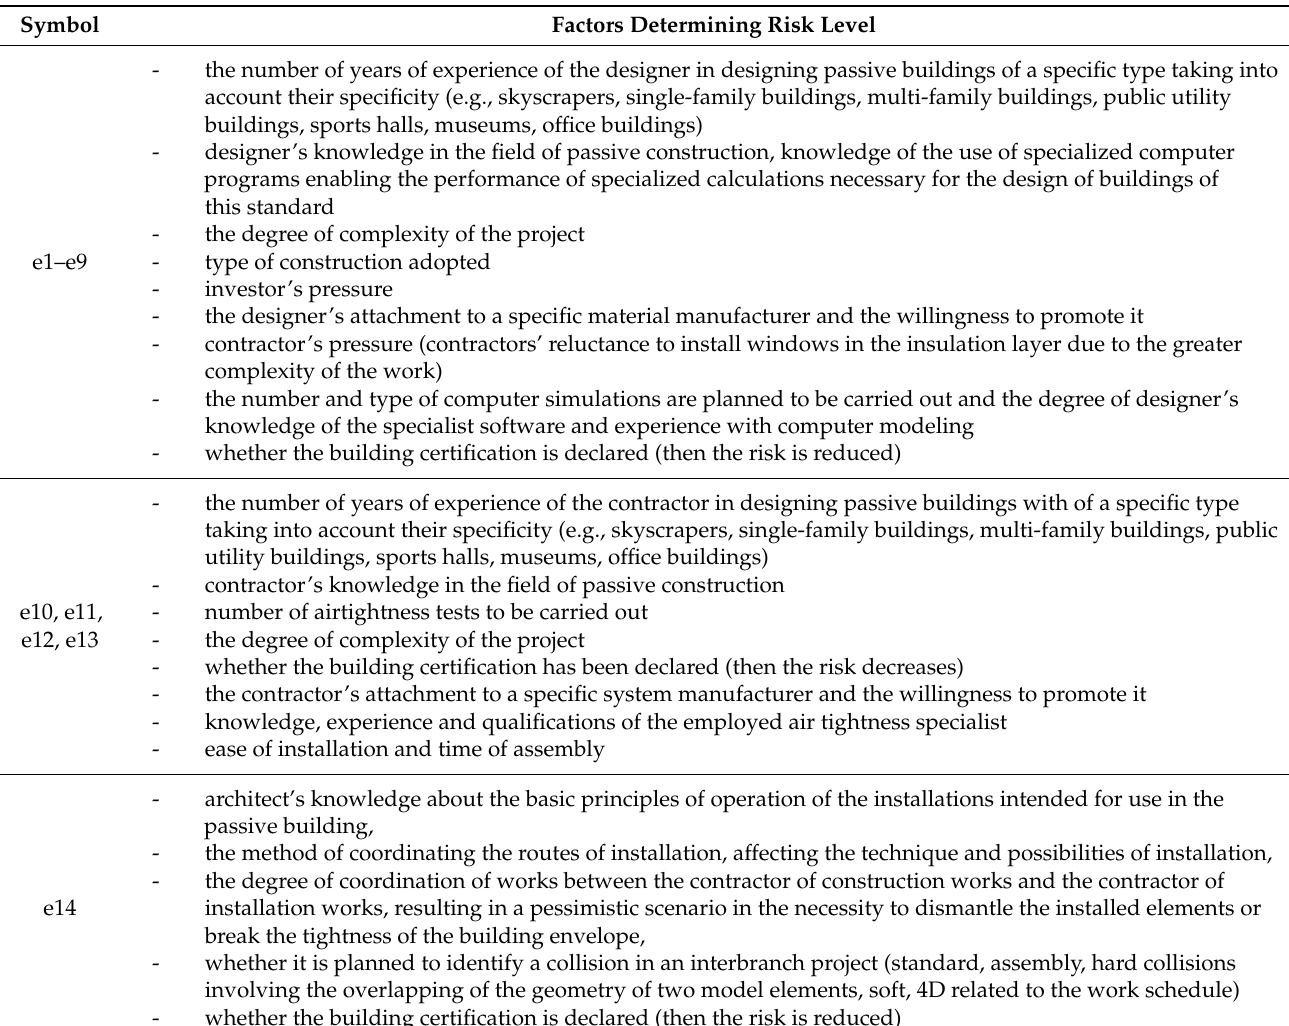
Table 3. The most important factors determining the risk level for each unwanted event in passive building investments.